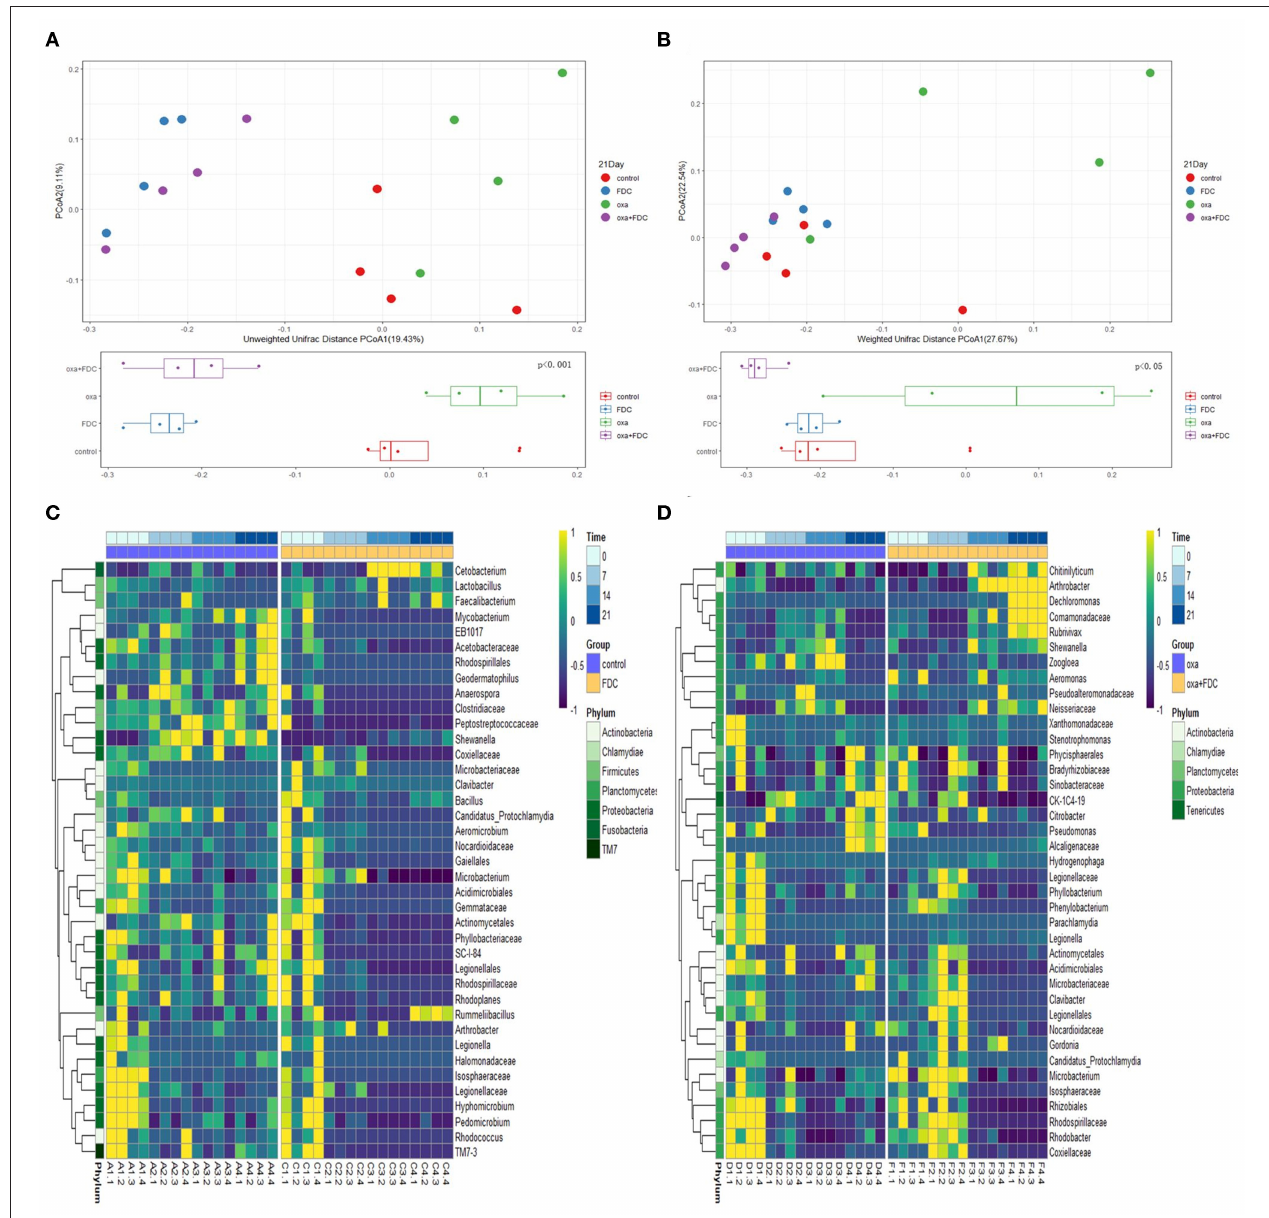
FIGURE 4 | Effects of FDC administration on the gut microbiota composition. (A,B) A principal component (PCoA) score plot based on unweighted and weighted UniFrac metrics for all samples on day 21. Each point represents the composition of the intestinal microbiota of one sample. (C,D) Heatmap constructed using the number of significantly different species on days 0, 7, 14, and